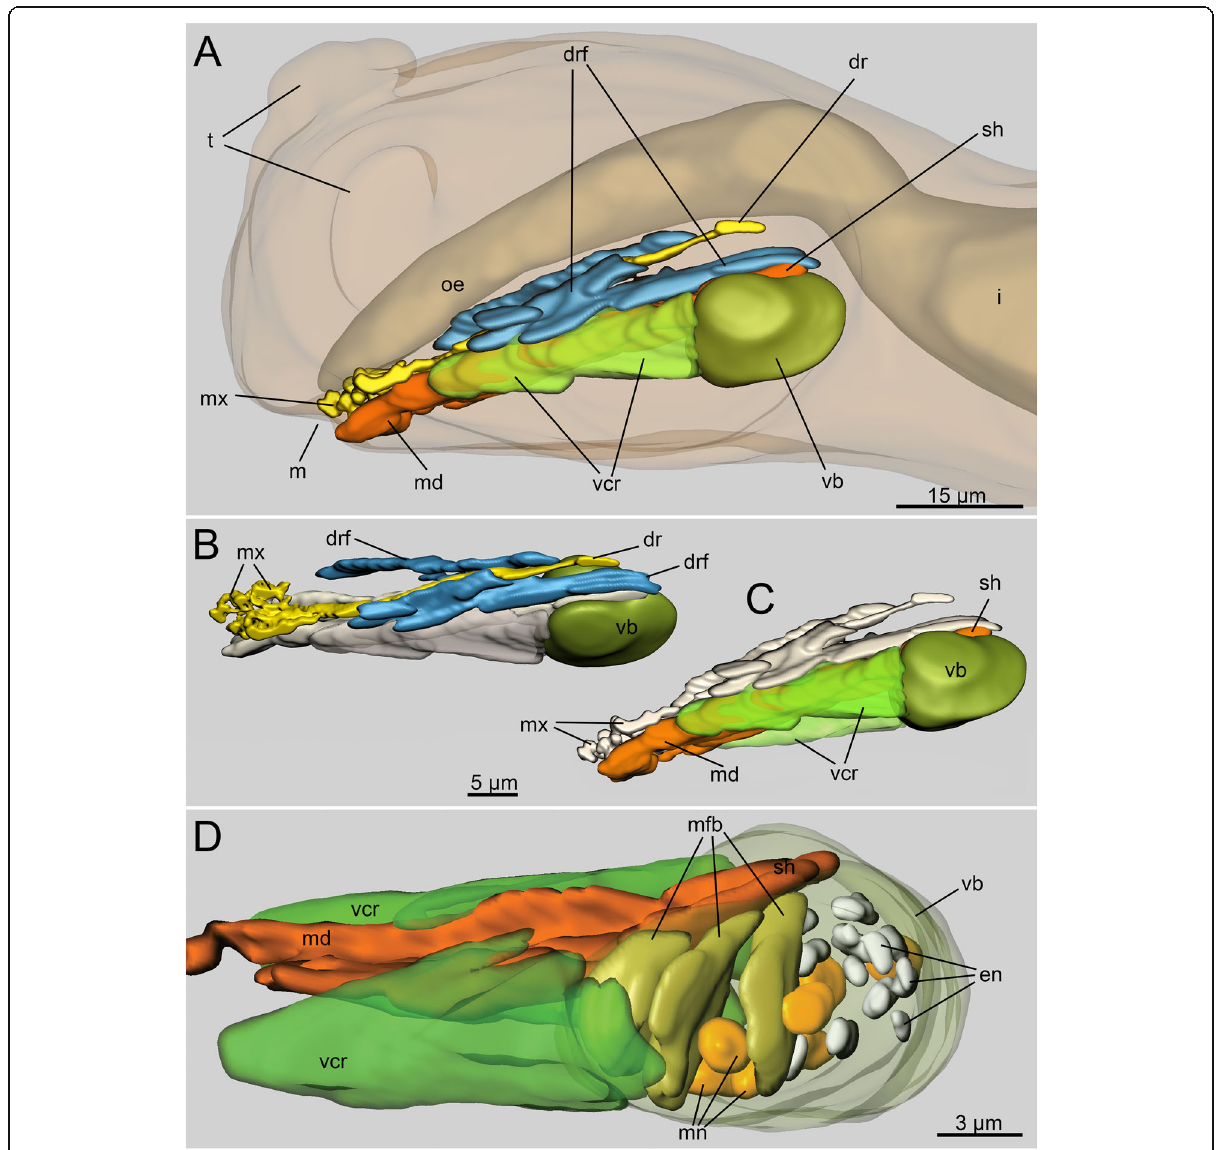
maxillae and dorsal rod – yellow; dorsal rod flexors – blue; mandibles and mandibular shaft – orange; ventral carrier retractors – light green; ventral muscle bulb – olive; epithelial nuclei – gray; muscular nuclei – light orange. a. General view of the head with the intestine, maxillae, mandibles and muscles. Lateral view. b. Ventral pharyngeal organ (VPO) and jaws, dorsolateral view. c. Ventral pharyngeal organ and jaws, ventrolateral view. d. Detailed reconstruction of the VPO. Lateral view. Drf, dorsal rod flexor; dr, dorsal rod; en, epithelial cell nuclei in the ventral muscle bulb; i, intestine; m, mouth; md, mandible; mfb, transversal muscle fibers of the ventral bulb; mn, muscular nuclei of the ventral bulb; mx, maxillae; oe, esophagus; sh, mandibular shaft; t, tentacle; vb, ventral muscle bulb; vcr, ventral carrier